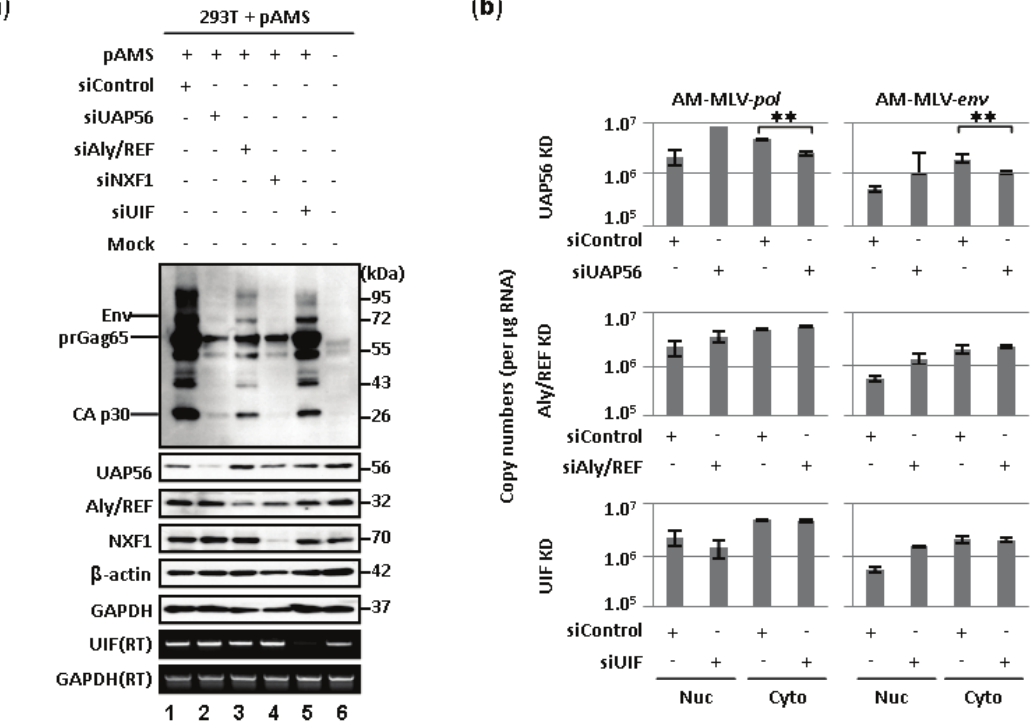
Figure 1. UAP56 is involved in the nuclear export of murine leukemia virus (MLV) transcripts. ( a ) Influence of disruption of adaptor proteins, UAP56, Aly/REF and UIF, on the expression of AM-MLV proteins in 293T cells transfected with pAMS. 293T cells were transfected with the indicated siRNA, and then transfected with 0.4 µg of pAMS at 24 h protein analysis; ( b ) RT-qPCR analysis of unspliced (AM-MLV- pol ) and